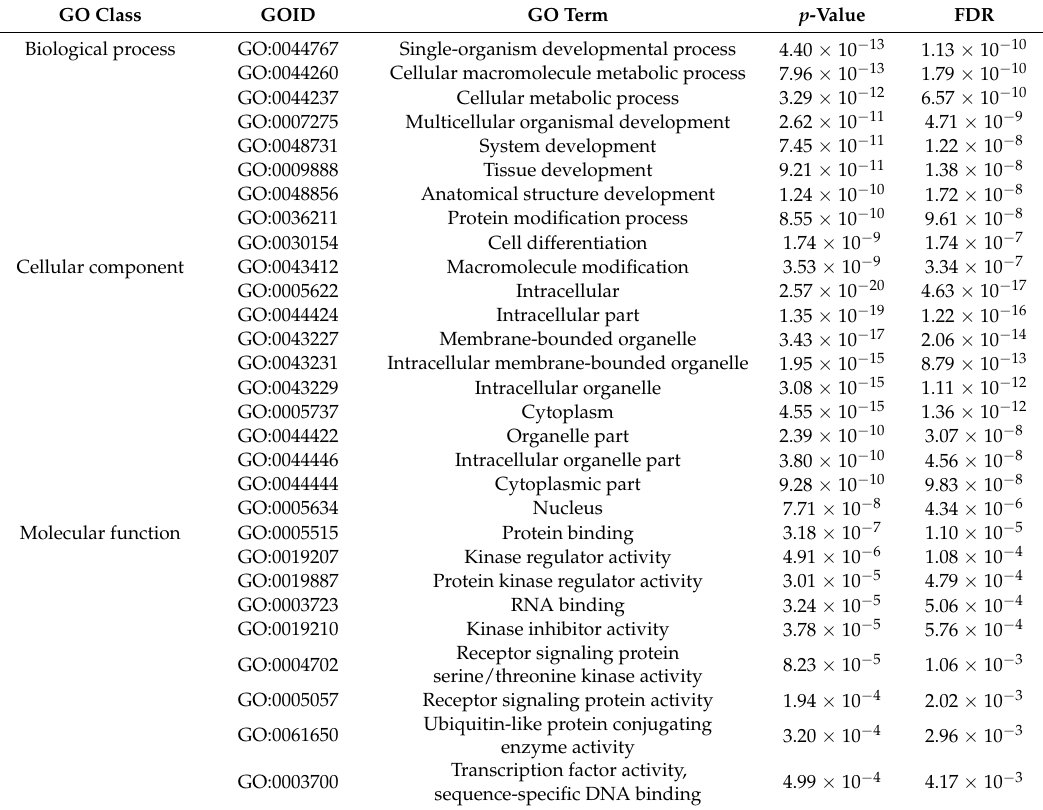
Table 2. Enriched gene ontology (GO) terms for target genes of 20 most abundantly expressed miRNAs. GO Class